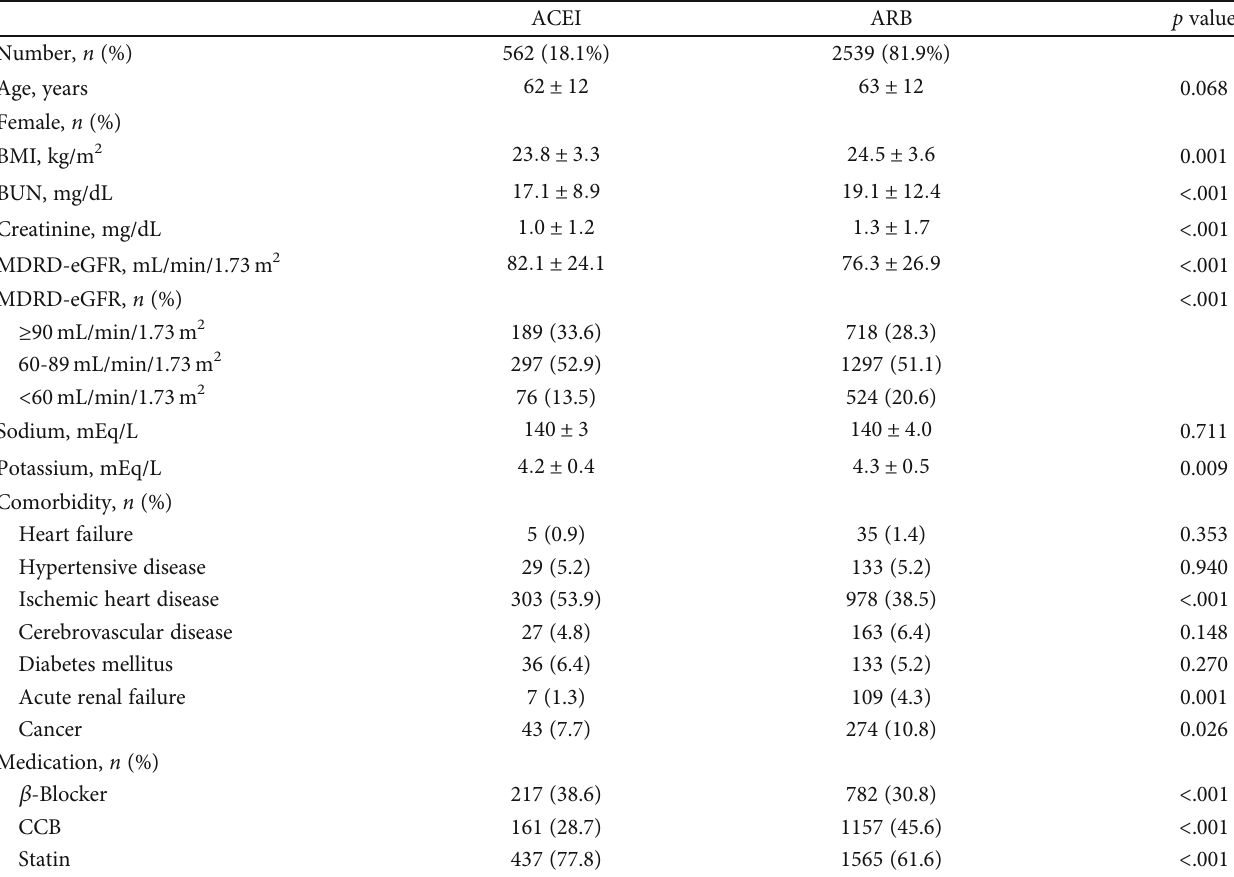
Table 1: Baseline characteristics of the patients ( n = 3101